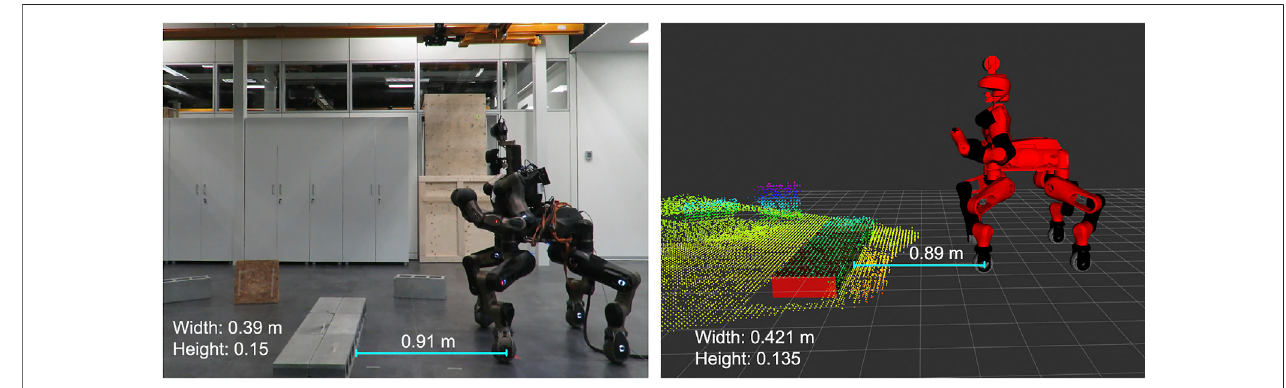
FIGURE8| Comparisonoftherealworldscenarioandtheperceivedone.Theerrorinbothdimensionsanddistancebetweenwheelsandobjectissmallerthanthe sensor resolution, 3 cm.